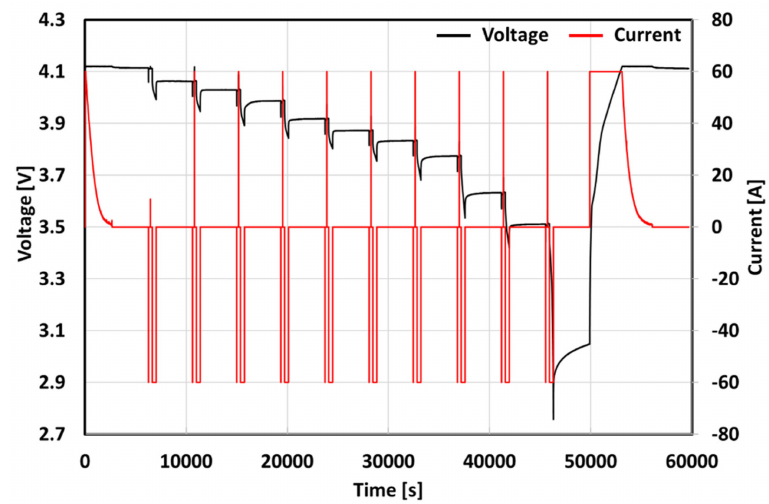
Figure 6. Pulse test performed with a prismatic lithium-ion battery cell with 10 s pulse at 1C charge (CC) and 1C discharge (CC-CV) and 3 min rest phase.